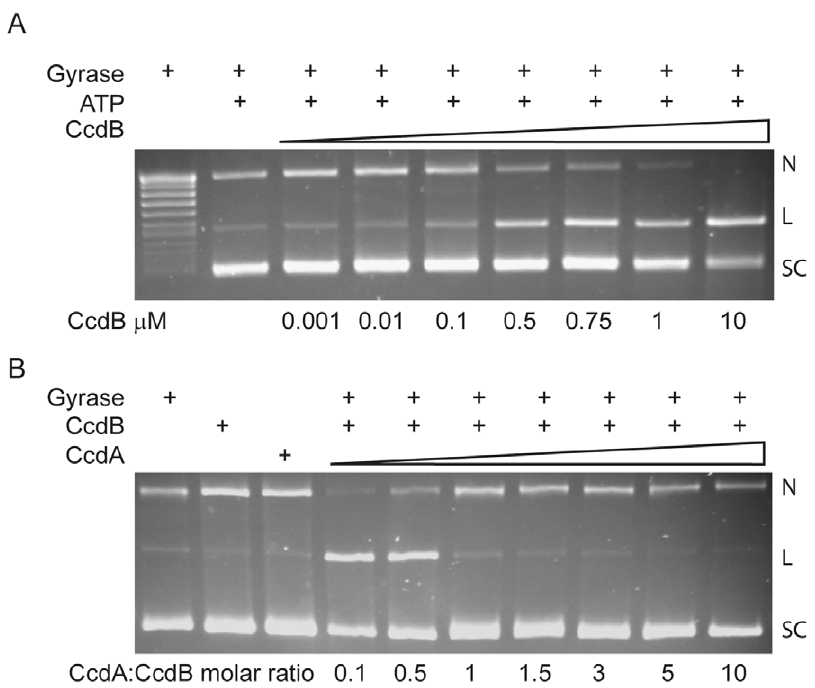
Figure 3. DNA gyrase-mediated cleavage of DNA, stimulated by CcdB. A. Negatively supercoiled pBR322 (3.5 nM) was incubated with 30 nM gyrase, 1.4 mM ATP and various concentrations of CcdB between 0.001–10 m M, as indicated, for 1 h at 25 u C. Cleaved DNA was revealed by the addition of SDS and proteinase K. After incubation for 30 mins at 37 u C, reactions were stopped with STEB and DNA was subjected to phenol extraction, and samples were analysed on a 1% agarose gel. N, nicked DNA; L, linear DNA; SC, supercoiled DNA. (B) CcdA inhibits the action of CcdB. Negatively supercoiled pBR322 was incubated with gyrase as described in (A) in the presence of 1.4 mM ATP, with 1 m M CcdB and various concentrations of CcdA between 0.1–10 m M as indicated. N, nicked DNA; L, linear DNA; SC, supercoiled